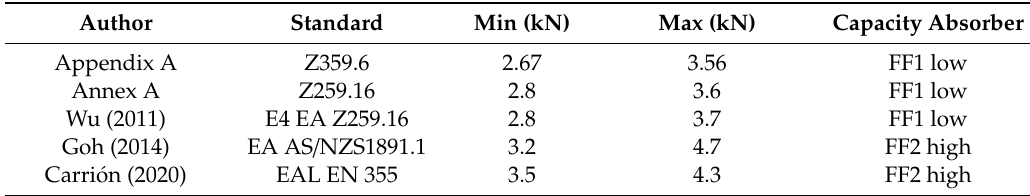
Table 14. Deployment average